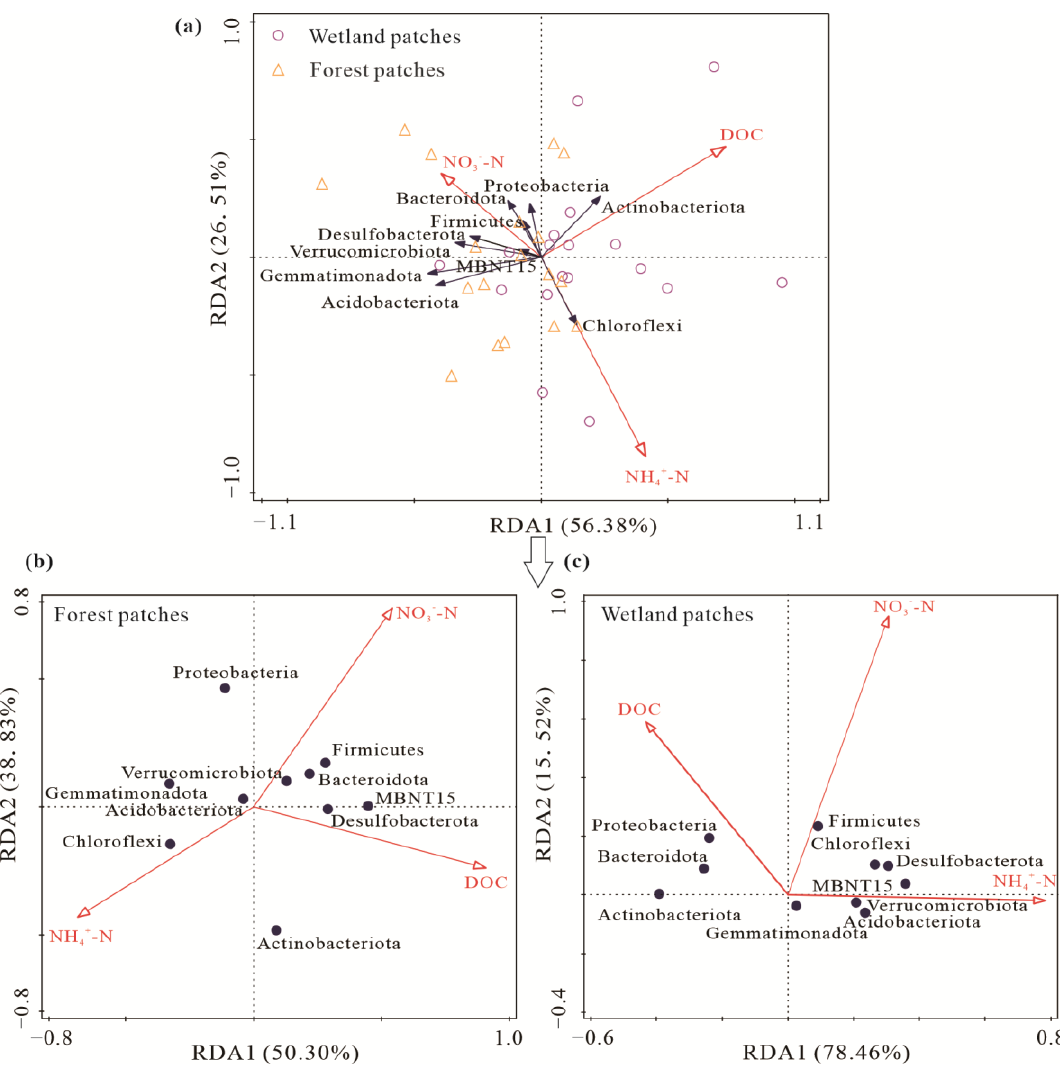
Figure 8. Redundancy analysis of soil bacterial phyla and the soil carbon and nitrogen contents in forest – wetland ecotone ( a ), forest patches ( b ) and wetland patches ( c ). Correlation analysis showed that the CH 4 emission rate was significantly positively correlated with soil DOC, NO 3 − -N contents, and Shannon index (Figure 9). CO 2 emission rate had a significantly negative relationship with Shannon index, while it was positively correlated with bacterial composition (Figure 9). In addition, soil CH 4 and CO 2 emis- sion rates showed the same correlation with substrates and bacterial diversity in different patches (Figure S1). To remove multicollinearity, stepwise multiple linear regression was used to find out the main biological and non-biological factors affecting CH 4 and CO 2 emissions in different patches (Table 2). Regardless of patch type, CO 2 and CH 4 emissions were affected by Proteobacteria. The main non-biological factors affecting the CH 4 emission rate were NO 3 − -N in forest patches and the NH 4+ -N and NO 3 − -N content for wetland patches. Variation in CO 2 emissions was largely explained by Chloroflexi, Proteobacteria, Actinobacteriota, MBNT5, and Gemmatimonadota for forest patches and by the Actinobac- teriota, Proteobacteria, Acidobacteriota, Gemmatimonadota, and Desulfobacterota for wetland